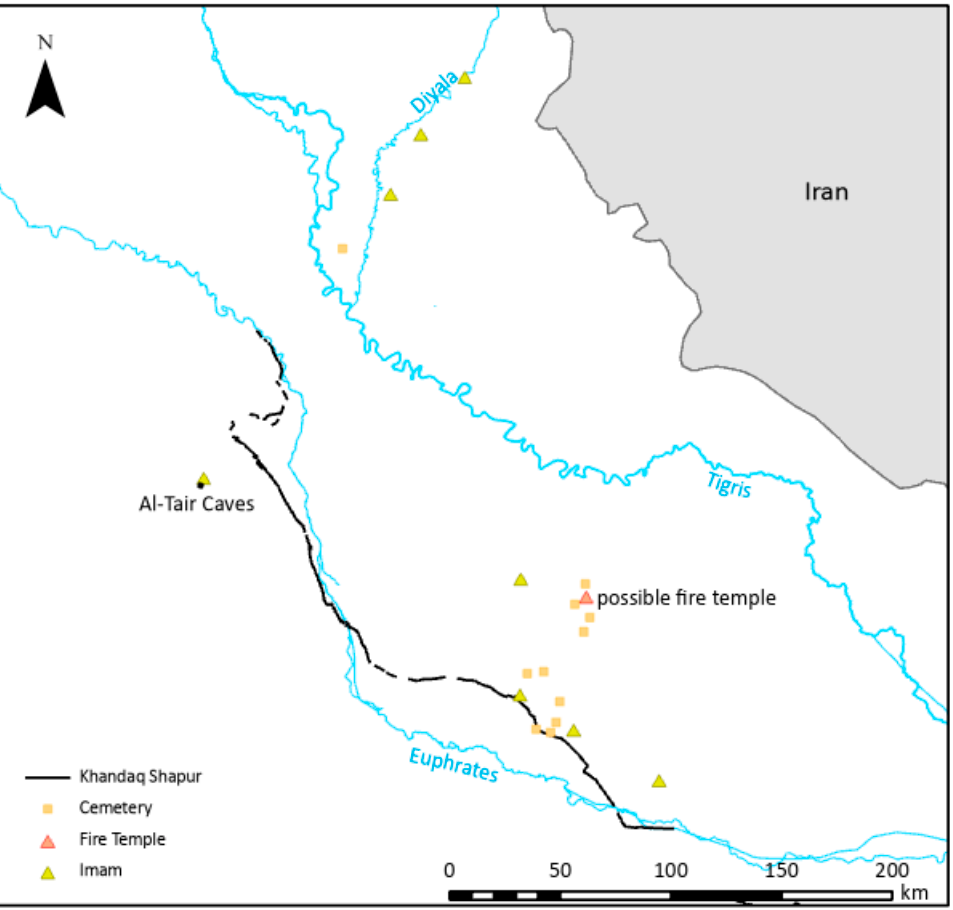
Figure 10. The Khandaq Shapur in relation to the Sasanian religious landscape, including docu- mented Sasanian shrines/imams, cemeteries, and a possible fire temple located by Adams [29].